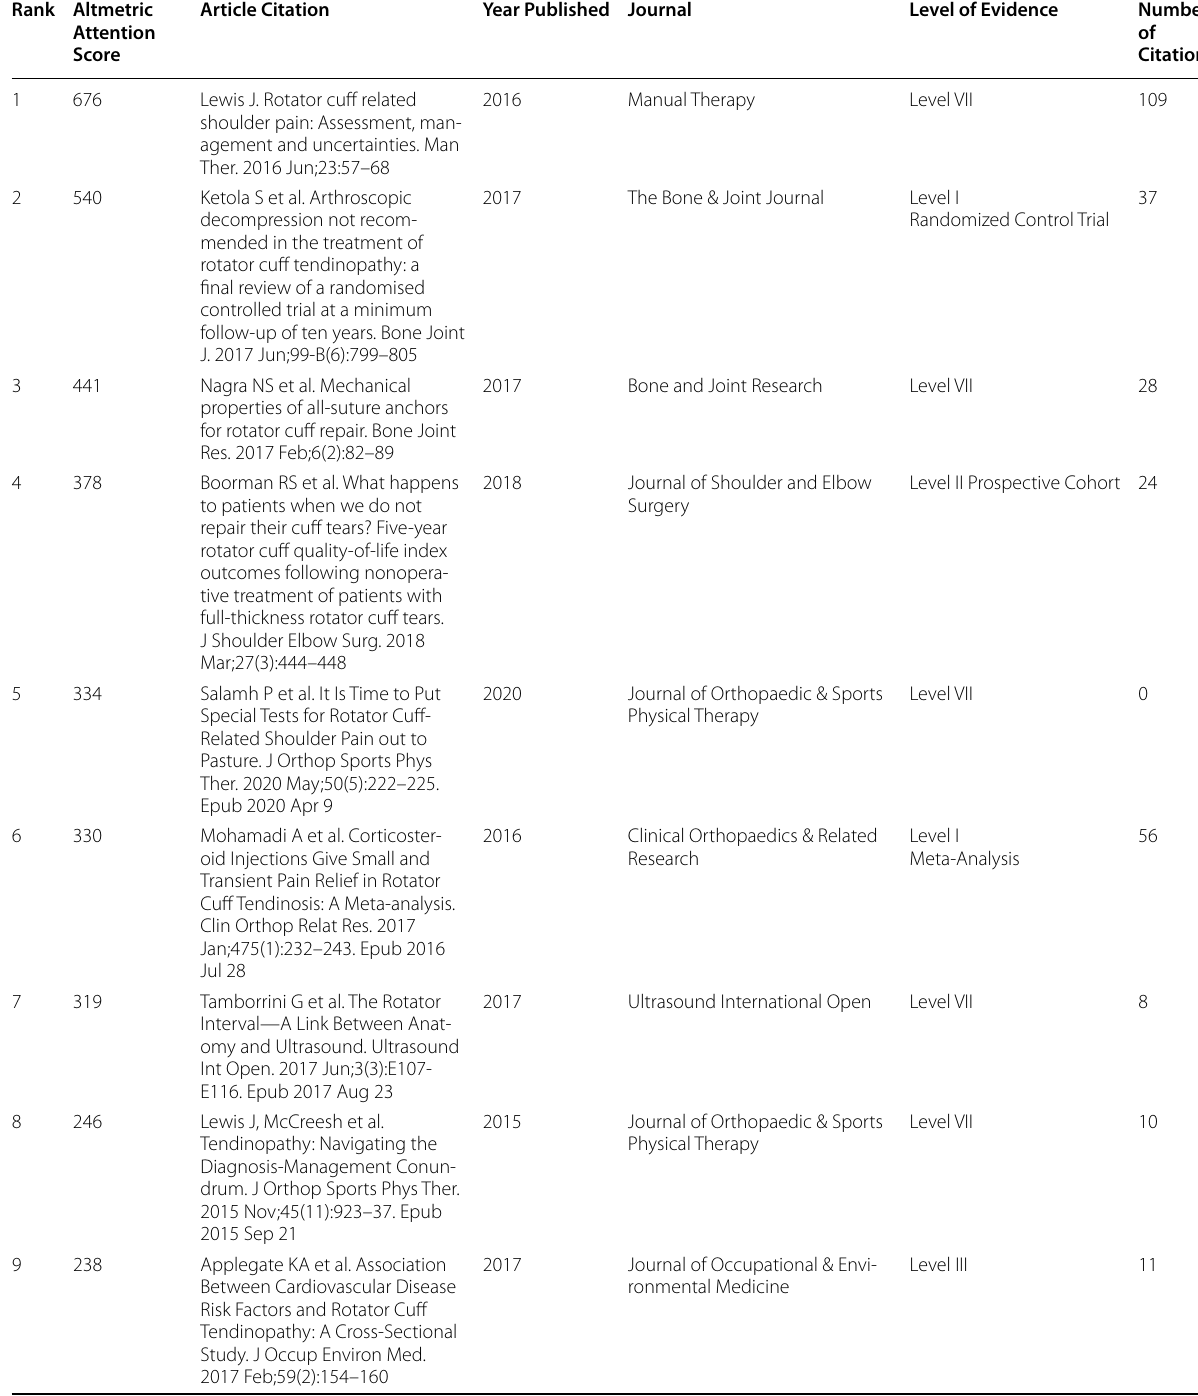
Table 1 Top 25 rotator cuff articles ranked by altmetric attention score Rank Altmetric